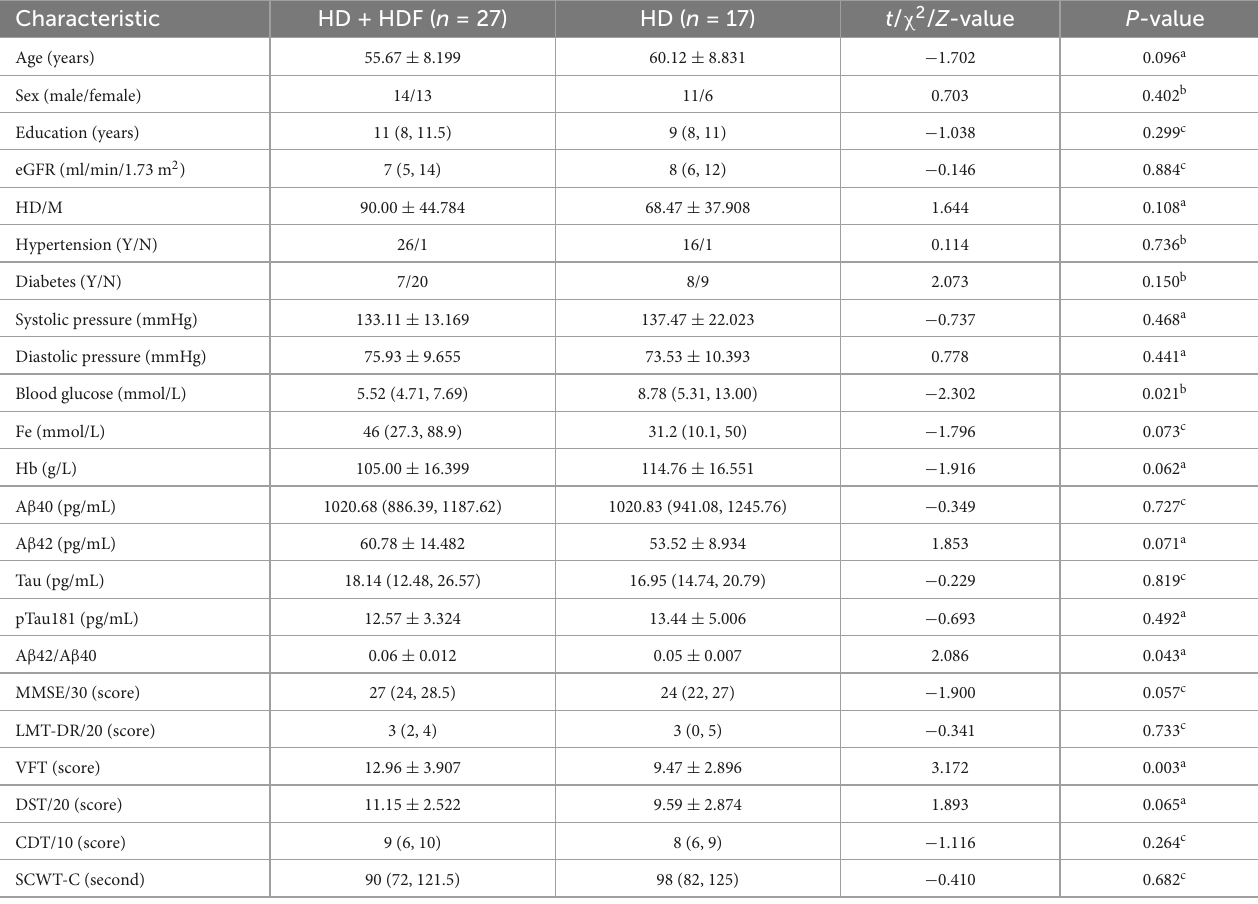
TABLE 2 Demographics, biochemical parameters, and neuropsychological tests of patients with ESRD-BP. Characteristic HD + HDF ( n = 27)